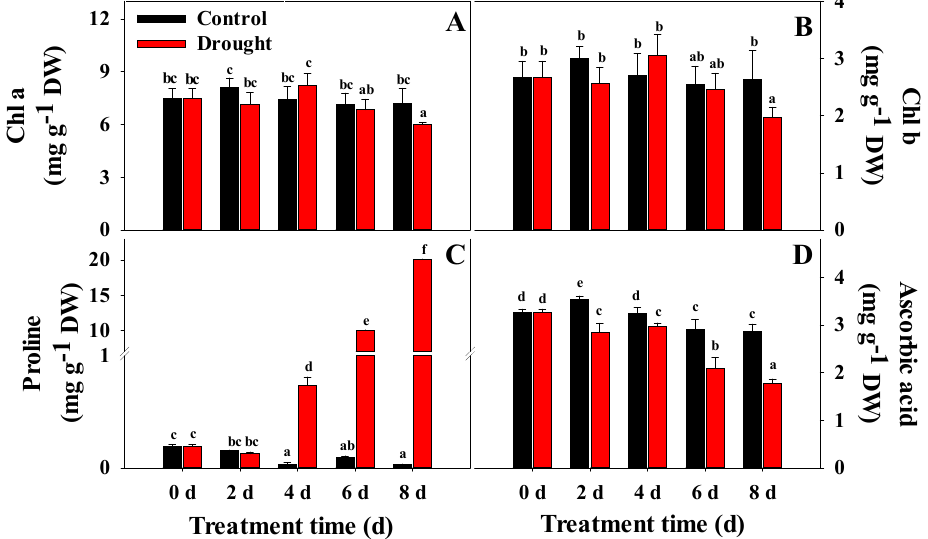
Figure 4. Effect of drought stress on Chl a ( A ), Chl b ( B ), proline ( C ), and vitamin C content ( D ) in lettuce seedlings during progressive treatment time. Vertical bars represent mean ± SD of three replicates, and the different letters indicate statistically significant differences by Duncan’s multiple range test at p < 0.05. Chl: chlorophyll.